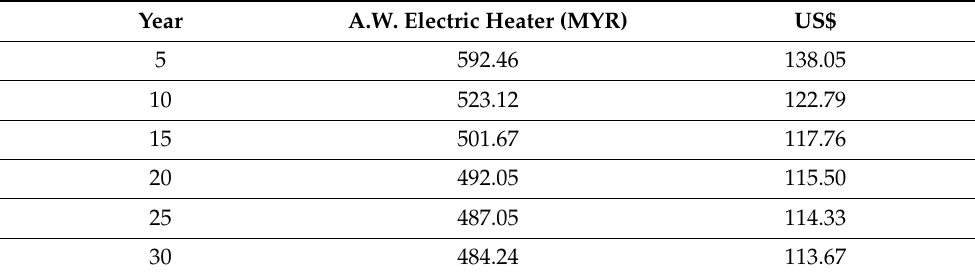
Figure A5. Electric heater cash flow diagram. Table A5. Cost of running an electrical heater.